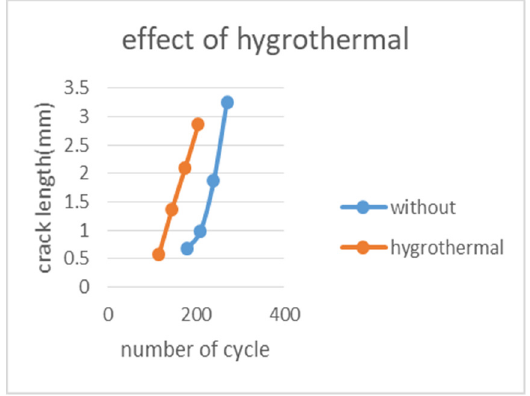
Fig. 10. Effect of hygrothermal on crack growth for 100cm specimens.